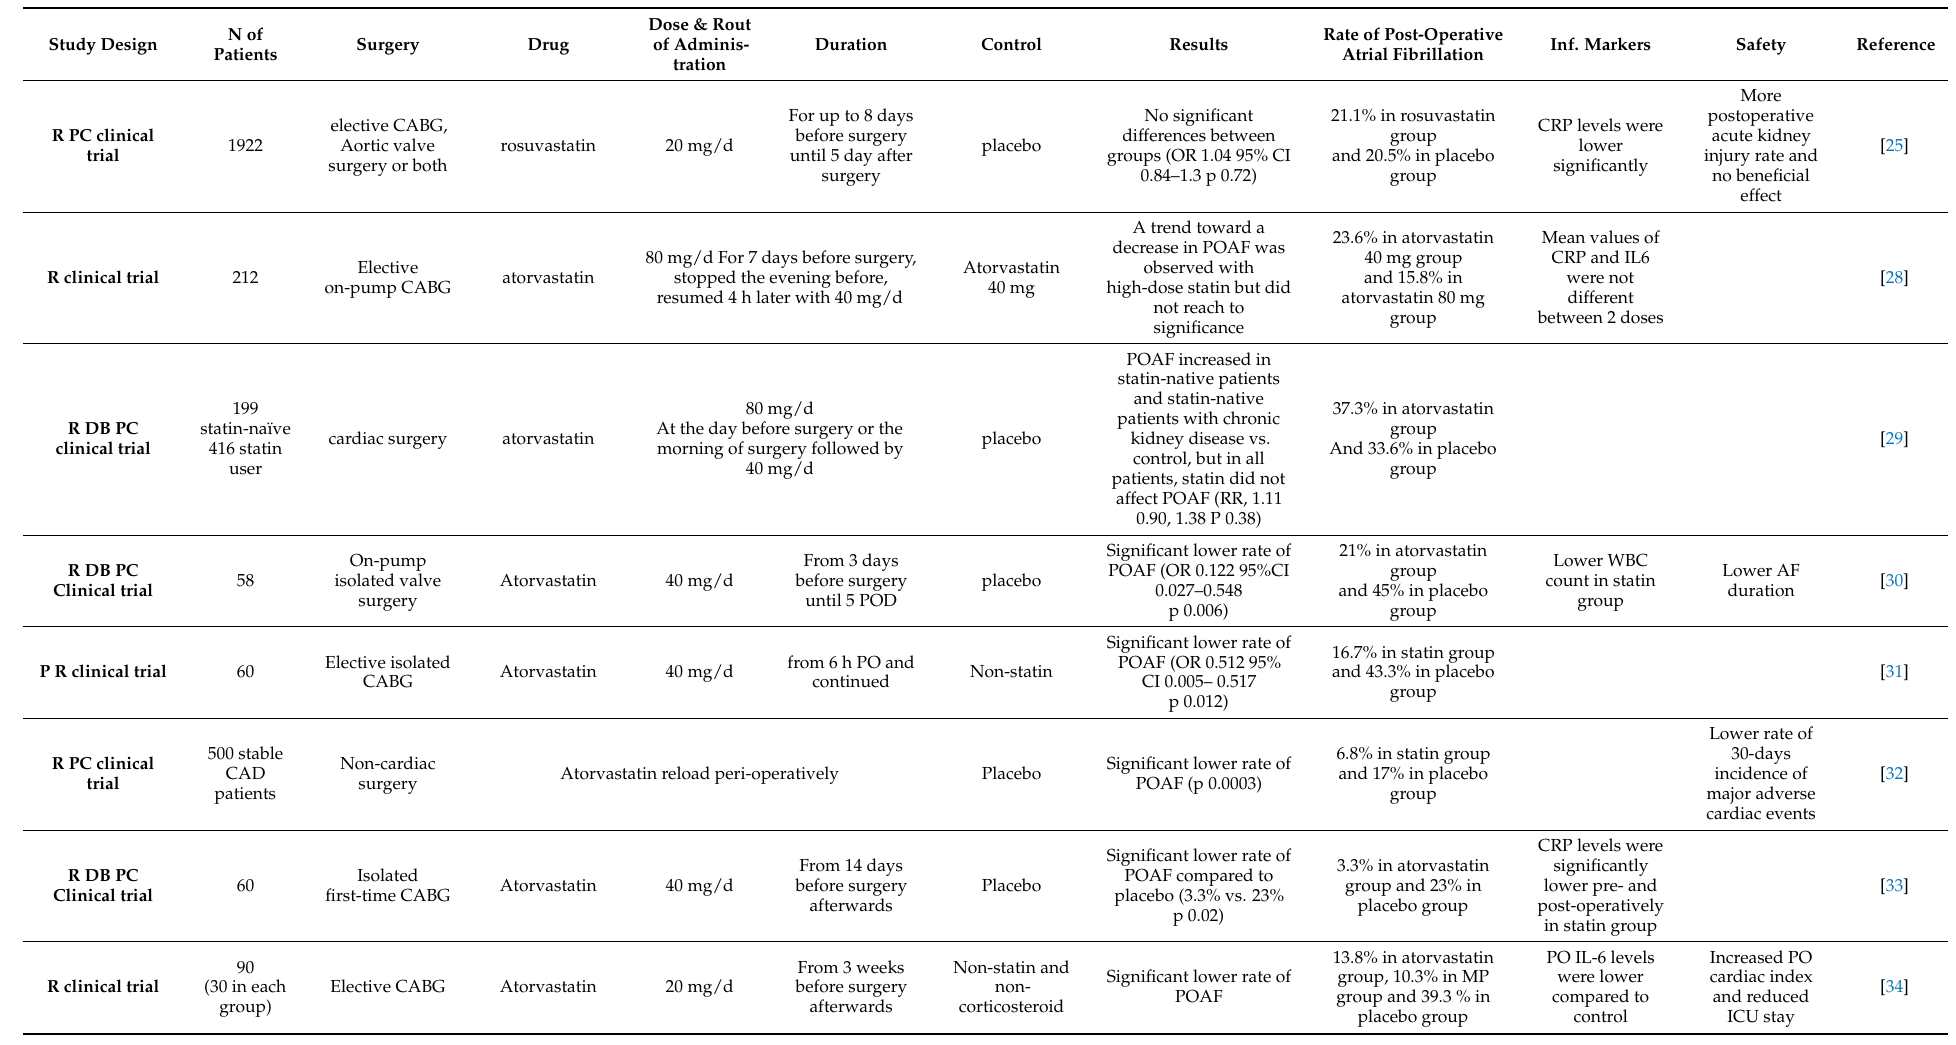
Table 1. Randomized clinical trials evaluating the effect of statins on the prevention of post-operative atrial